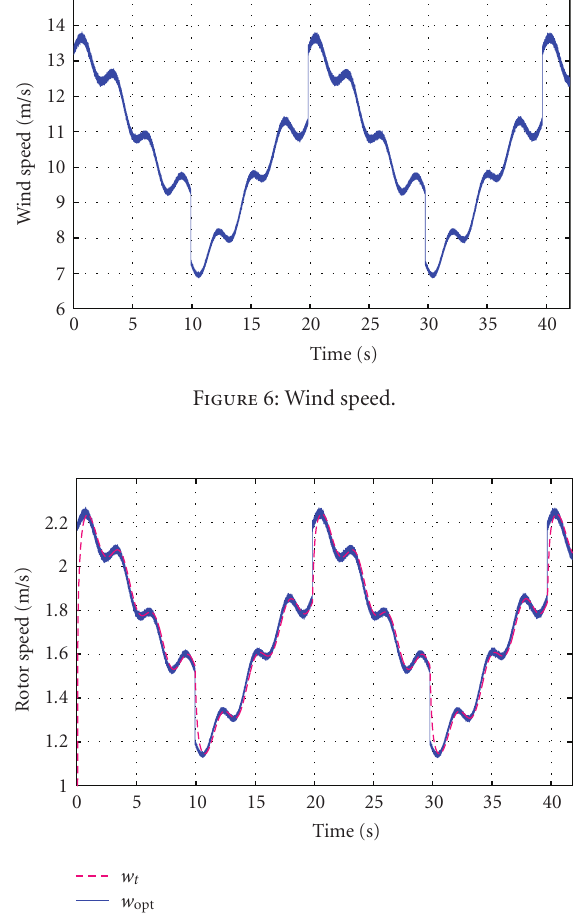
Figure 5: Membership functions of states.